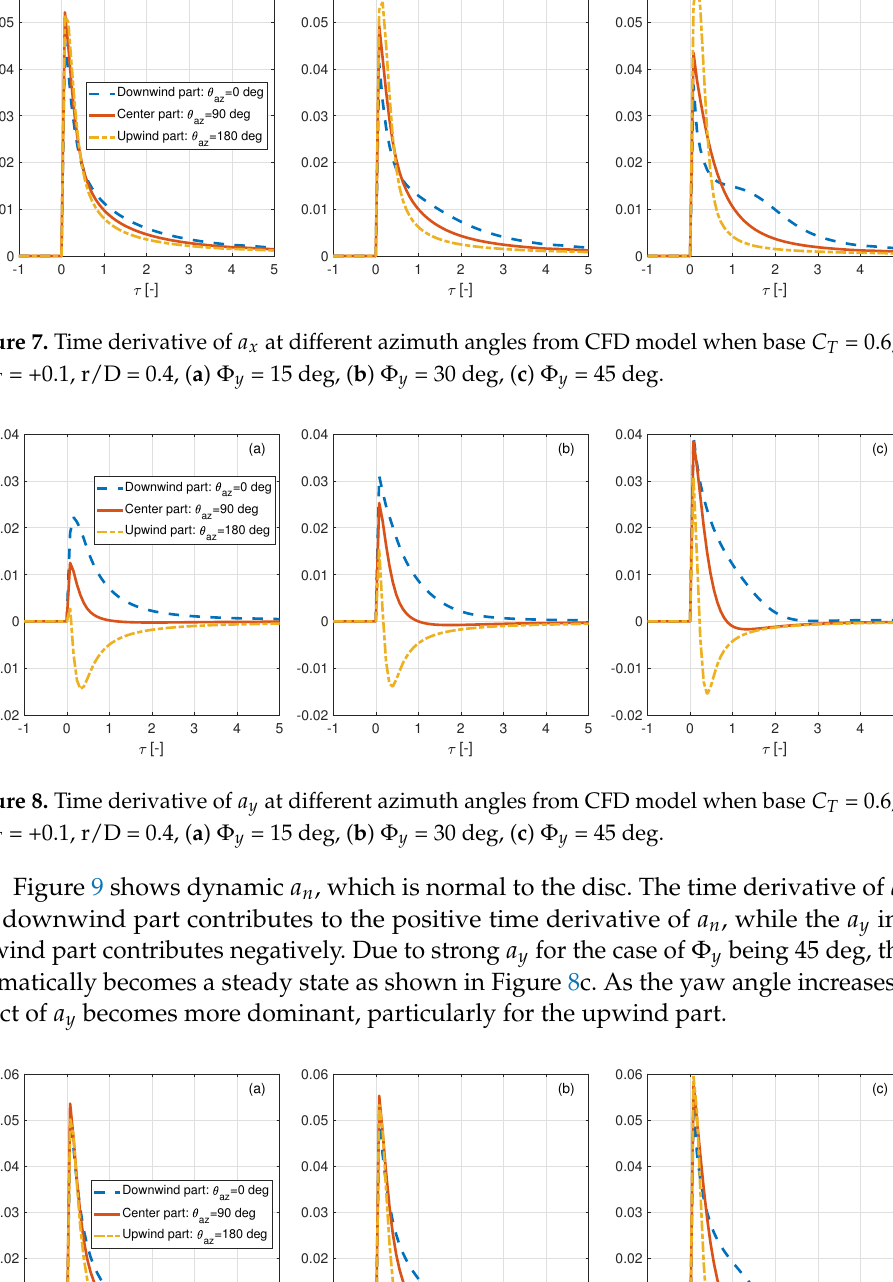
Φ Φ Φ y = 15 deg, ( b ) y = 30 deg, ( c ) y = 45